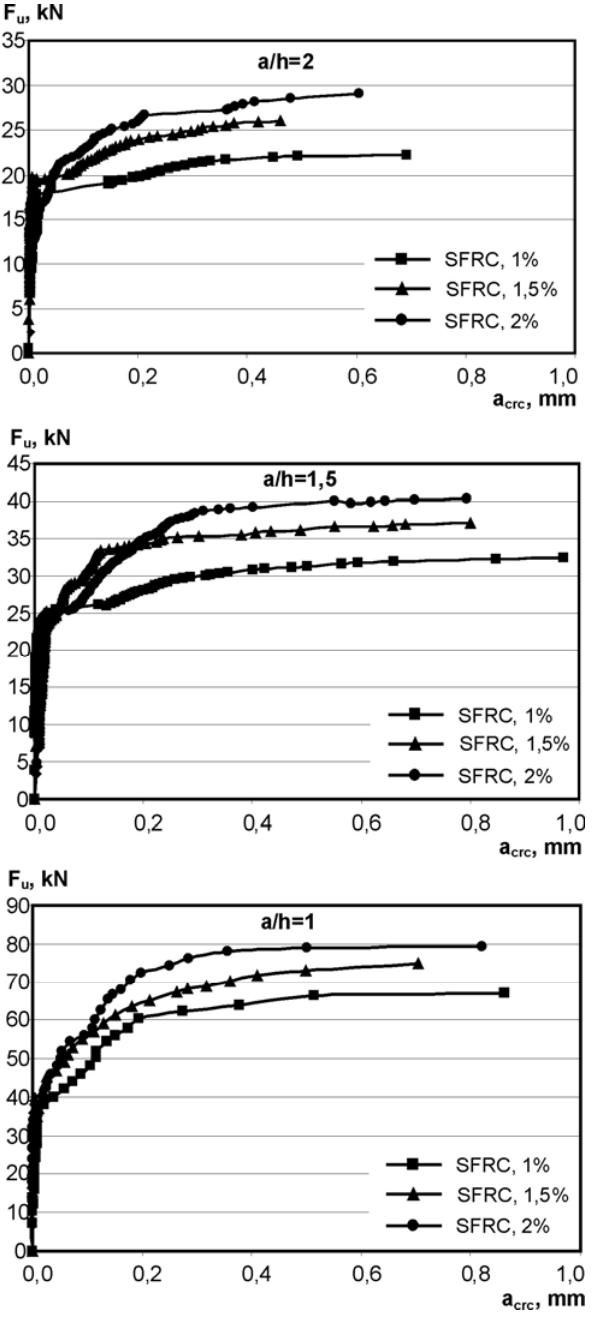
Fig 6. Cracking of elements with various fibre volumes V and shear span ratios / a h f